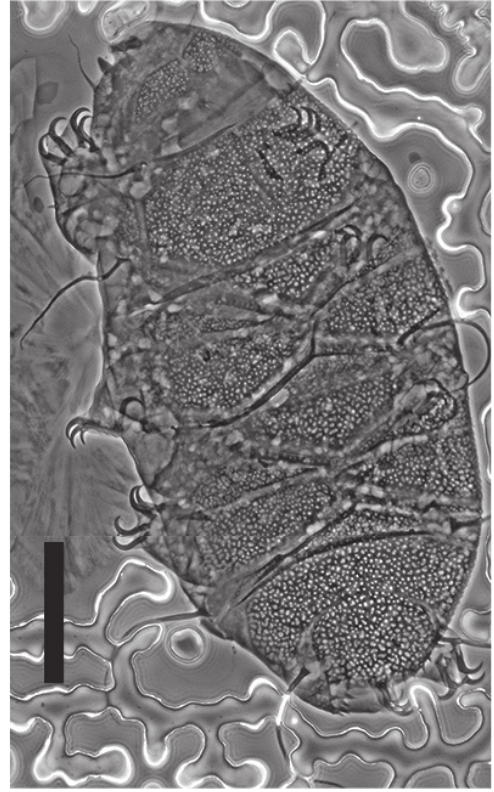
Figure 1. Echiniscus cf. quadrispinosus from Swaziland. Scale bars: 50 μm.